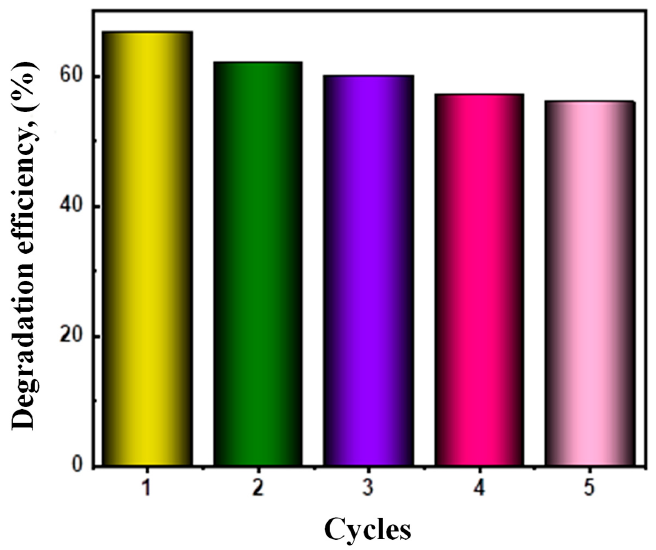
Figure 6. Recycling of 0.001 G/N-doped ZnO nanostructured.